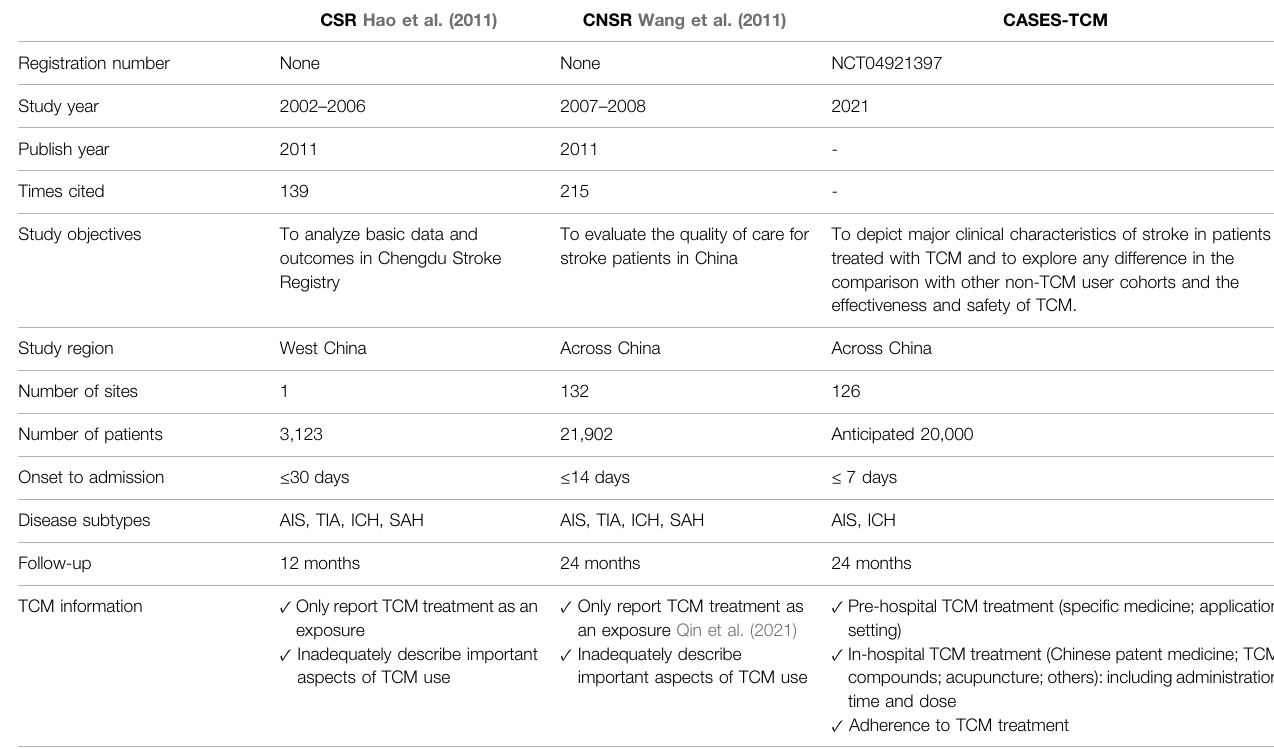
TABLE 3 | Comparison of CSR, CNSR, and CASES-TCM